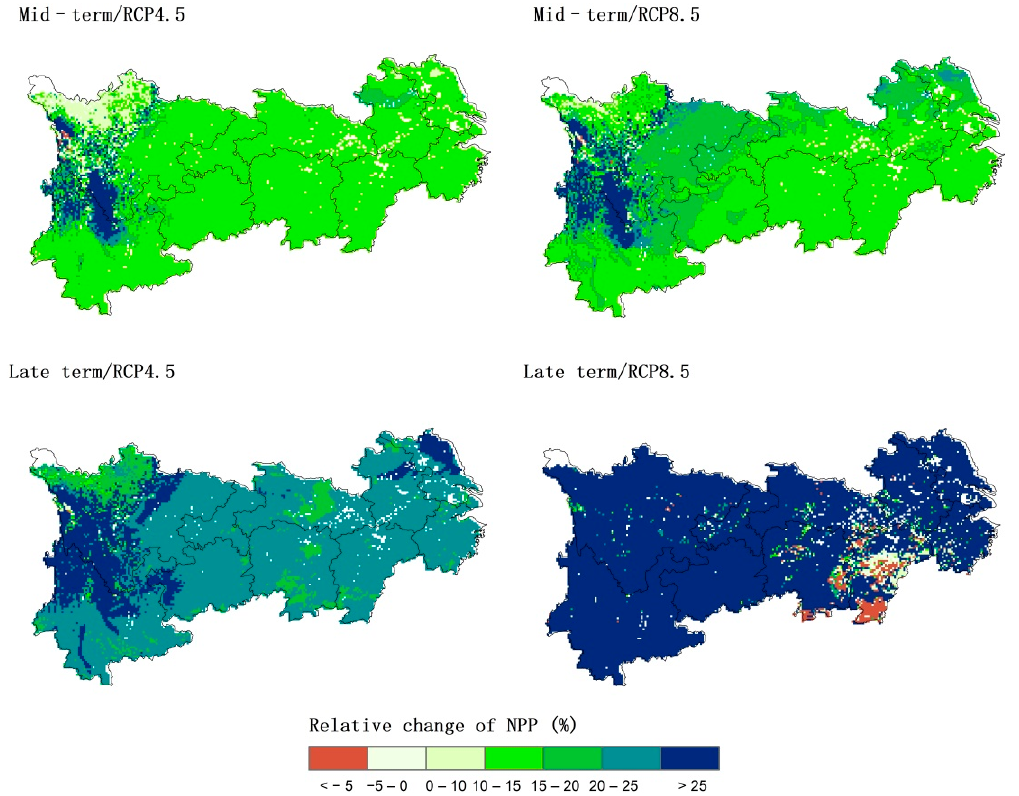
Figure 6. Spatial change patterns of NPP in the mid − term and the late − term 21st century under the RCP4.5 and RCP8.5 scenarios compared with the reference period in the YREB.